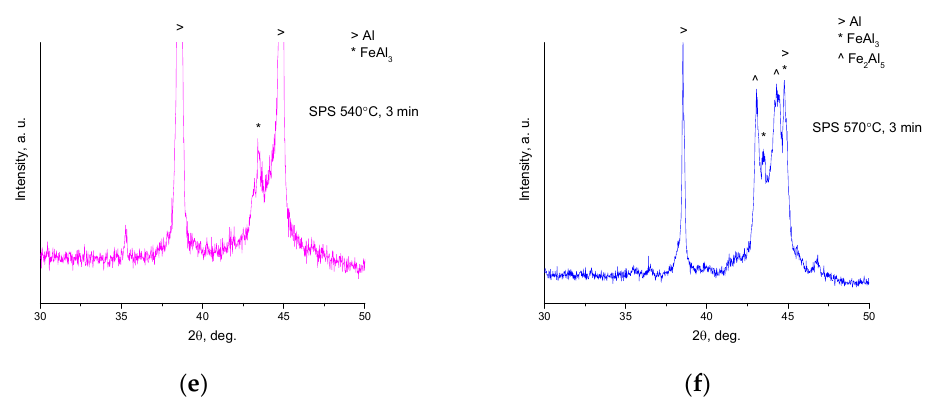
Figure 2. XRD patterns of composites obtained from Al-20 vol.% Fe 66 Cr 10 Nb 5 B 19 mixtures: ( a ) spark plasma sintering (SPS) at 540 °C, no holding, and SPS at 540 °C, no holding/forging at 450 °C; ( b , c ) enlarged portions (30–50°) of the XRD patterns of samples shown in ( a ); ( d ) SPS at 540 °C, 3 min, and SPS at 570 °C, 3 min; ( e , f ) enlarged portions (30–50°) of the XRD patterns of samples shown in ( d ).